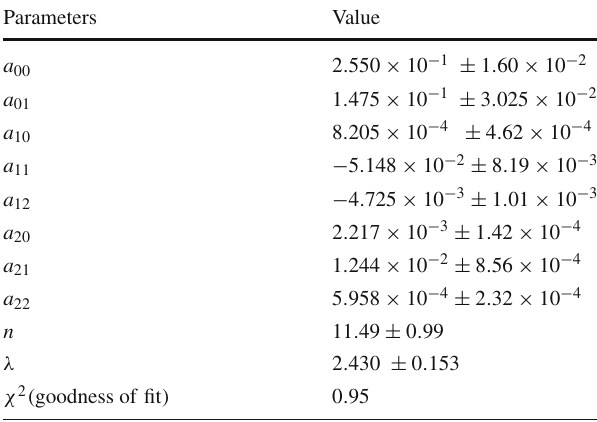
Table 1 The effective parameters at low x for 0 . 15 GeV 2 < Q 2 < 3000 GeV 2 provided by the following values. The fixed parameters are defined by the Block–Halzen fit to the real photon–proton cross section as M 2 = 0 . 753 ± 0 . 068 GeV 2 and μ 2 = 2 . 82 ± 0 . 290 GeV 2 Parameters